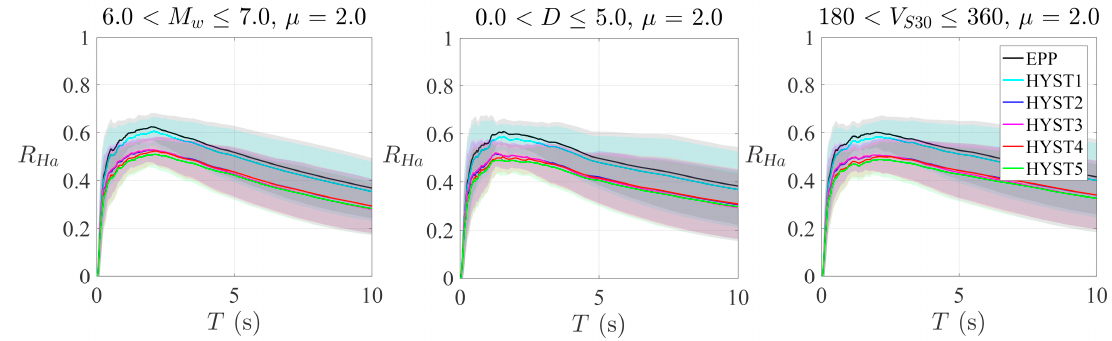
Figure 8. Influence of the hysteretic model on the spectra of absolute input energy reduction factor R Ea for a ductility level µ equal to 2 (filled area: envelope of the spectra; solid line: mean spectrum).